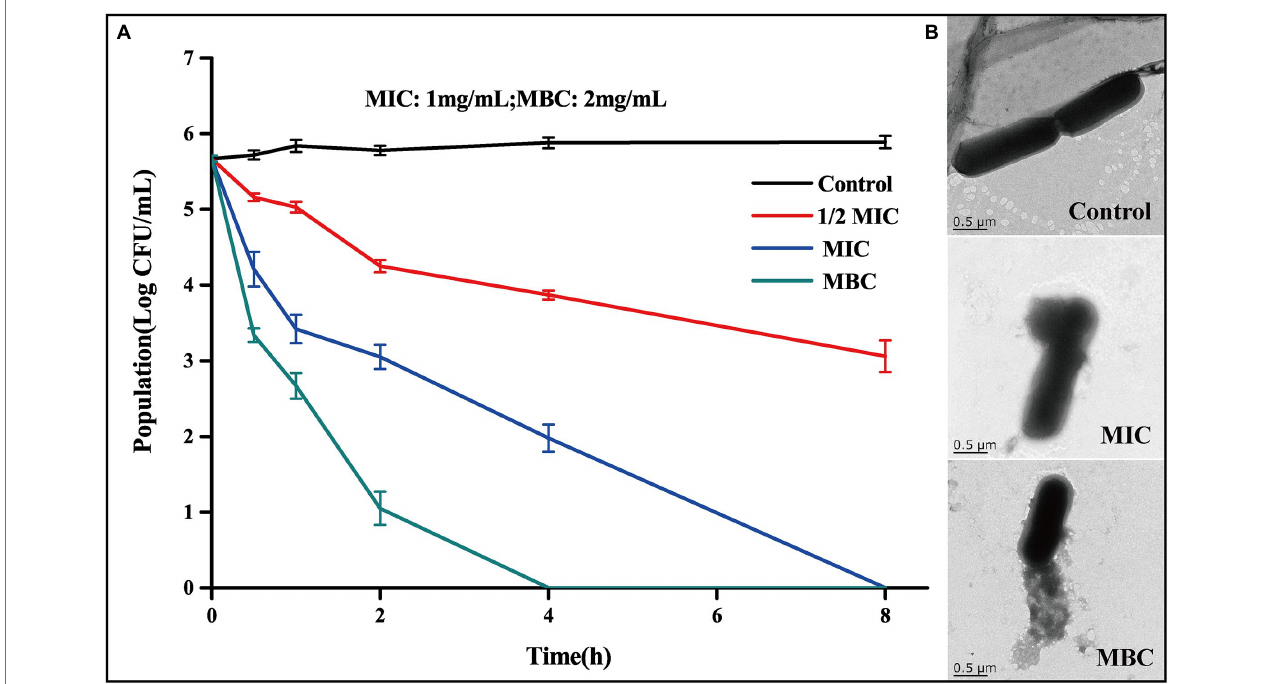
FIGURE 2 | Time kill curve of BEO against Listeria monocytogenes (A) ; TEM images of L. monocytogenes before and after BEO [minimum inhibitory concentration (MIC), minimum bactericidal concentration (MBC)] treatment (B)